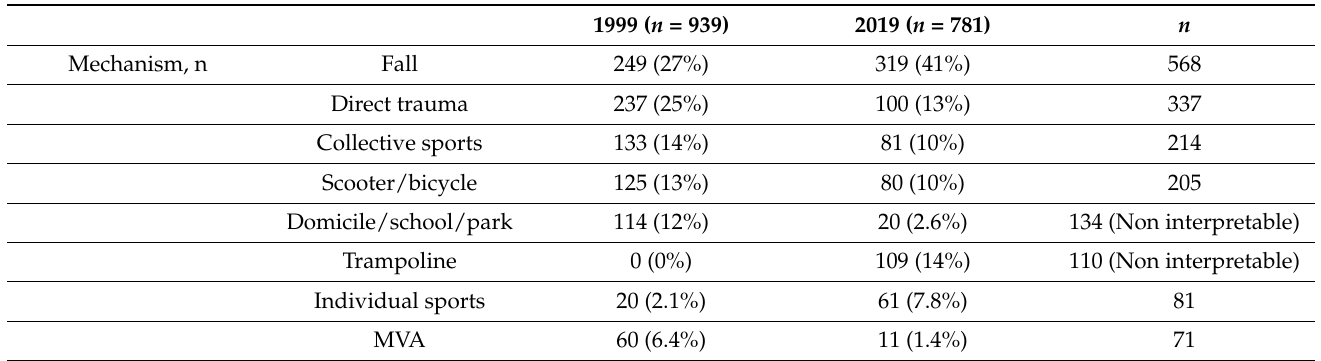
Table 2. Mechanism of injury in 1999 and 2019.